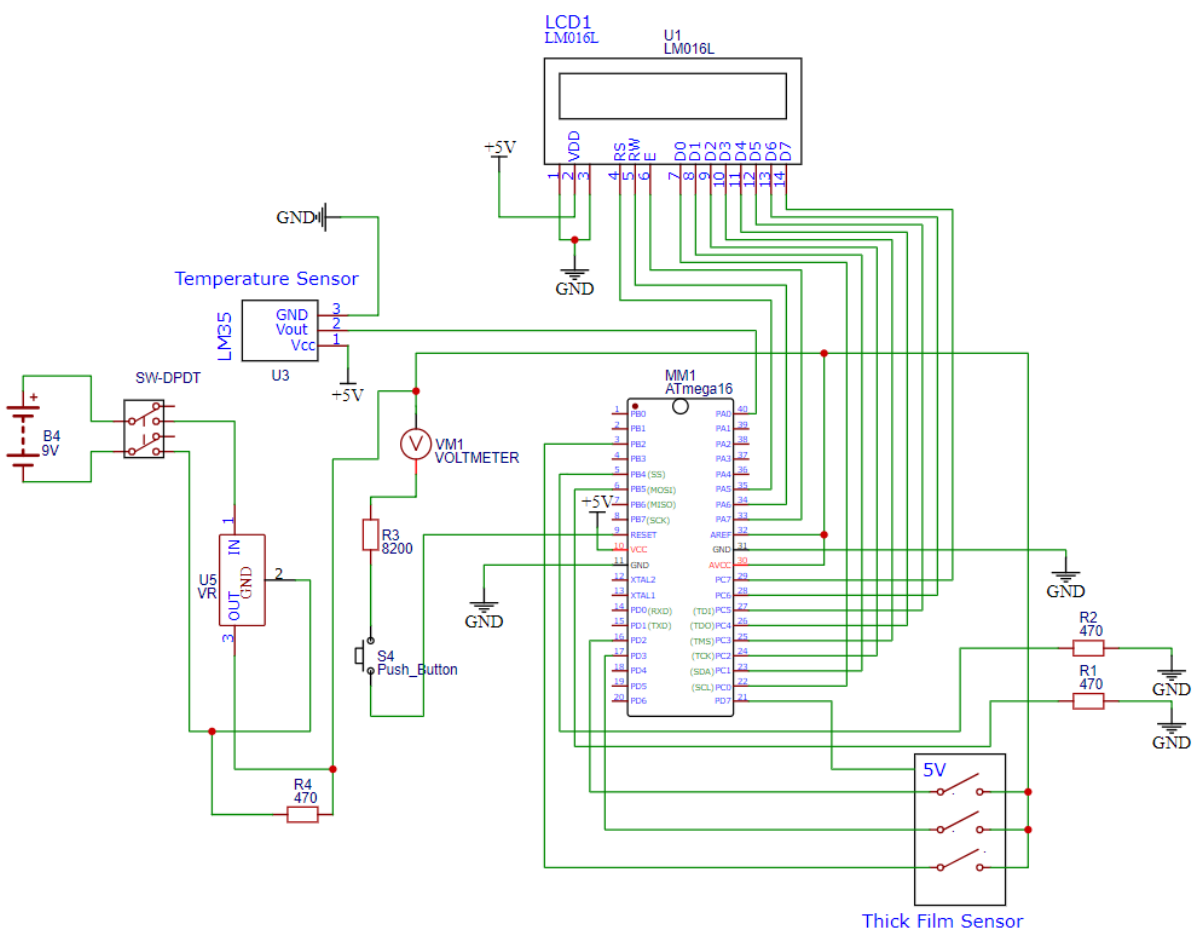
Figure 5. Tool wear-out detection system